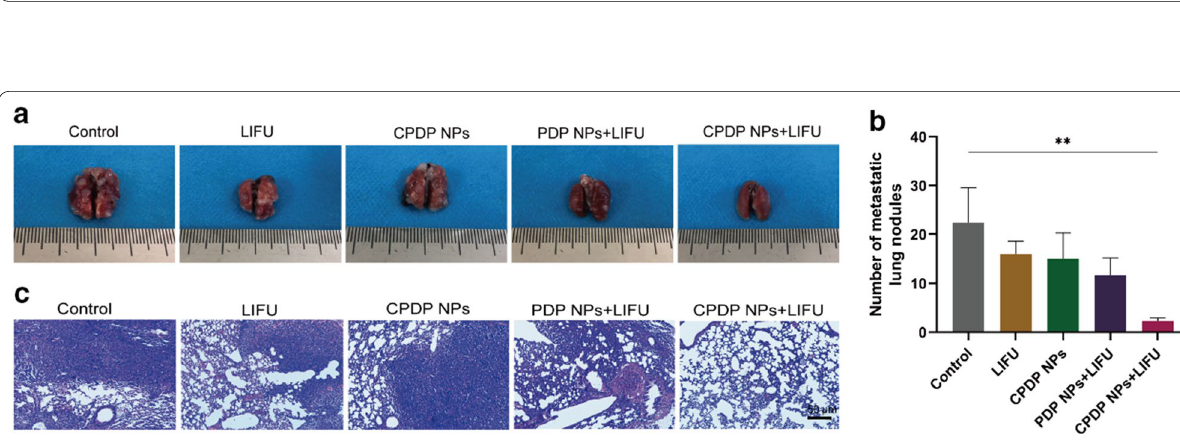
Fig. 9 a The weights of healthy Kunming mice under various concentrations of CPDP NPs ( n examination under various concentrations of CPDP NPs within a certain period of 30 days ( n spleen, lung, and kidney) of mice under the same treatment (scale bar: 50 μm)